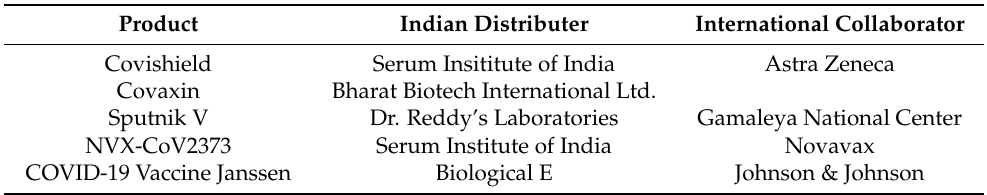
Table 1. The five different vaccines manufactured in India. Own illustration, data compiled from the BBC, Ministry of Health and Family Welfare [11,24,32]. Product Indian Distributer International Collaborator Covishield Serum Insititute of India Astra Zeneca Covaxin Bharat Biotech International Ltd.